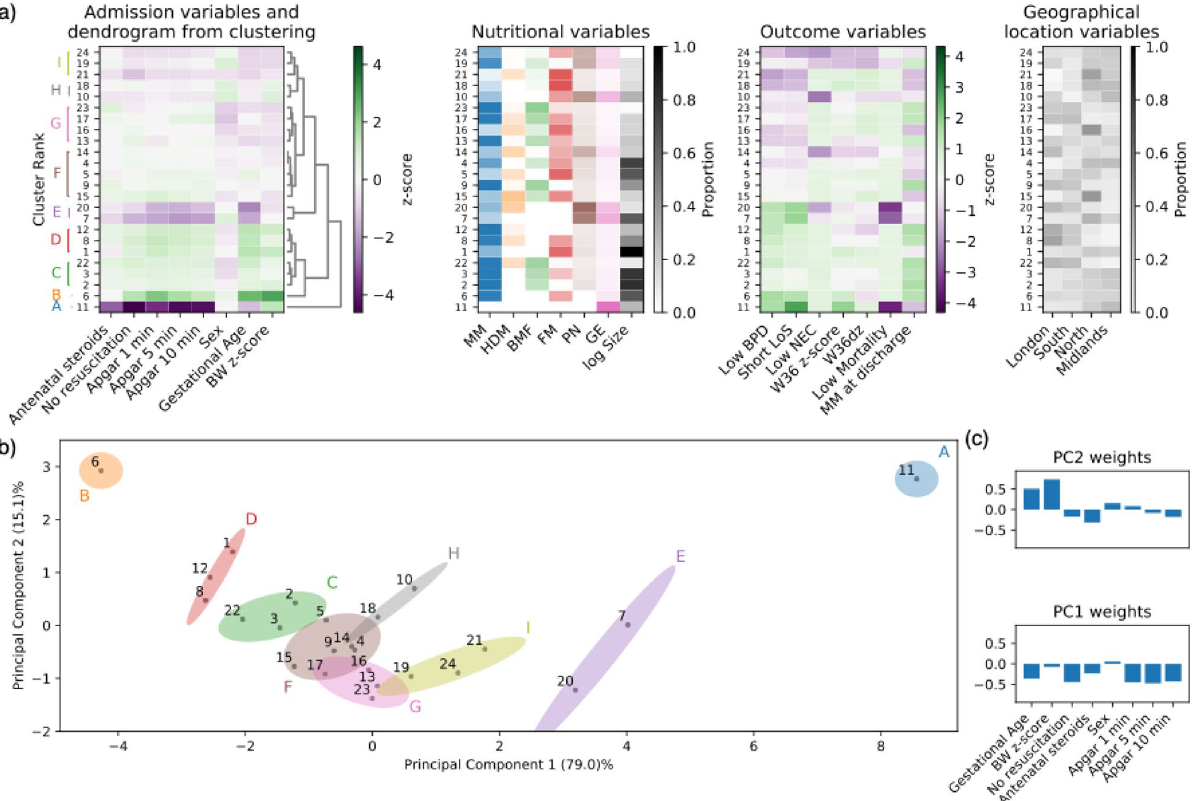
Figure 3. Aggregation of nutritional clusters based on admission variables identifies 9 admission groups to further assess association with geographical location and outcome variables. Hierarchical clustering and PCA performed on the 24 most populated nutritional clusters (covering 95% of the whole cohort) using admission variables (shown in ( a )) to characterize infants in each cluster. Nutritional clusters indexed according to size rank. The 9 admission groups, defined by visual inspection, are encoded with letters A to I on the hierarchical clustering dendrogram ( a ) and on the PCA projection plot ( b ). ( a ) Admission z-scores values (used for clustering), along with outcome variables (z-scores), nutritional and geographical location variables (mean proportions, Table 2). Colour coding for admission and outcome variables uses green for “favourable” and purple for “unfavourable” values (e.g. a high z-score value is unfavourable for NEC while favourable for MM at discharge). Feature columns in admission, outcome and geographical location variables are also reordered based upon hierarchical clustering. ( b ) Projection of the nutritional clusters (plotted as points with cluster index as in ( a )) along the two main principal components returned by PCA (PC1 and PC2, explaining 94% of the variance). Admission groups A to I from ( a ) are reproduced on the PCA plot with ellipses whose axes are based on the covariances of the group’s coordinates along PC1 and PC2. ( c ) Contributions of individual admission variables to the first two principal components (PC1 and PC2). PC1 is driven by gestational age, resuscitation and Apgar scores, while PC2 is driven by gestational age and birth weight